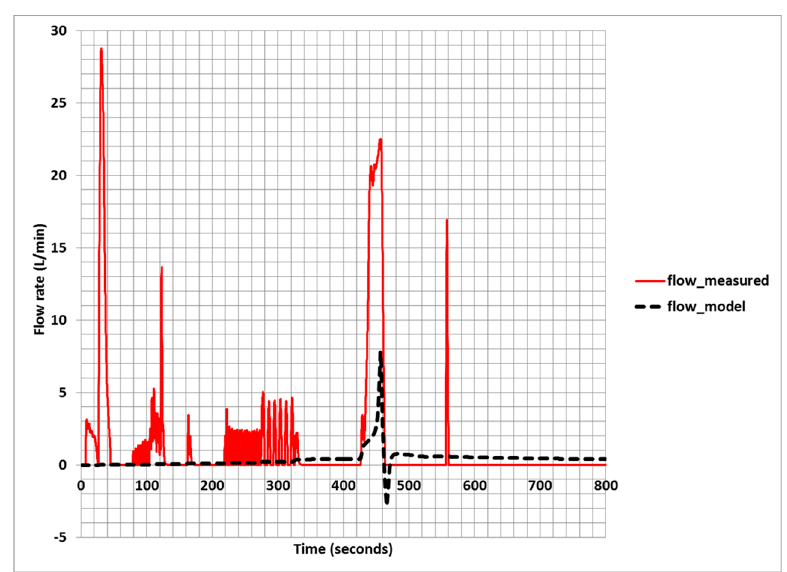
Figure 5. Fault failure and opening and permeability at highest injection pressure. ( a ) The deformed shape is shown with a high degree of exaggeration. The failure zone is shown in red and corresponds to the largest opening of the fault. ( b ) The distribution of permeability parallel to the fault plane is shown in log scale.